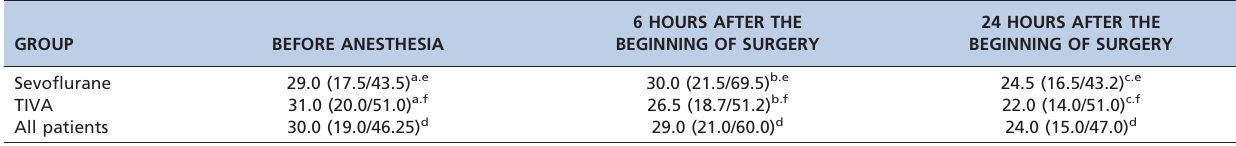
a Comparison of the values in the SEVO vs . TIVA groups for M0, p =0.376. b Comparison of the values in the SEVO vs . TIVA groups for M1, p =0.309. c Comparison of the values in the SEVO vs . TIVA groups for M2, p =0.917. d Comparison of the values in all of the patients across different periods: M1-M0, p =0.227; M2-M1, p =0.533; and M2-M0, p =0.894. e Comparison of the values within the SEVO group across different periods: M1-M0, p =0.083; M2-M1, p =0.913; and M2-M0, p =0.421. f Comparison of the values within the TIVA group across different periods: M1-M0, p =0.914; M2-M1, p =0.715; and M2-M0, p